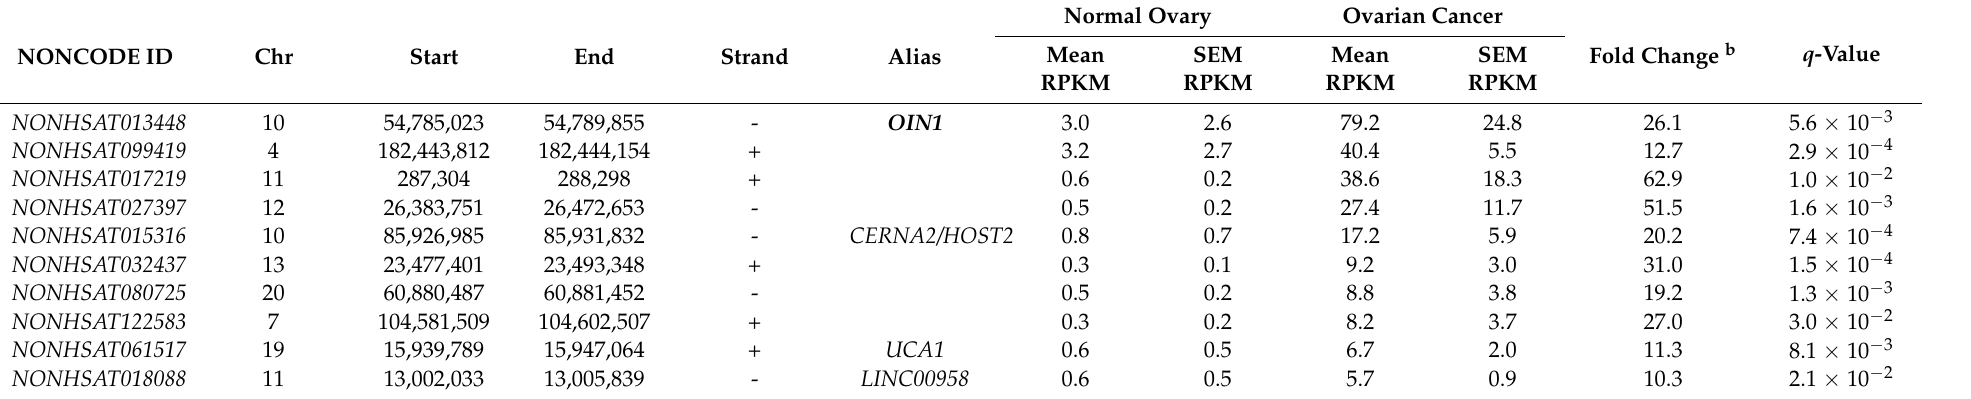
Table 1. Differentially upregulated lincRNAs in ovarian cancer versus normal ovary tissues a